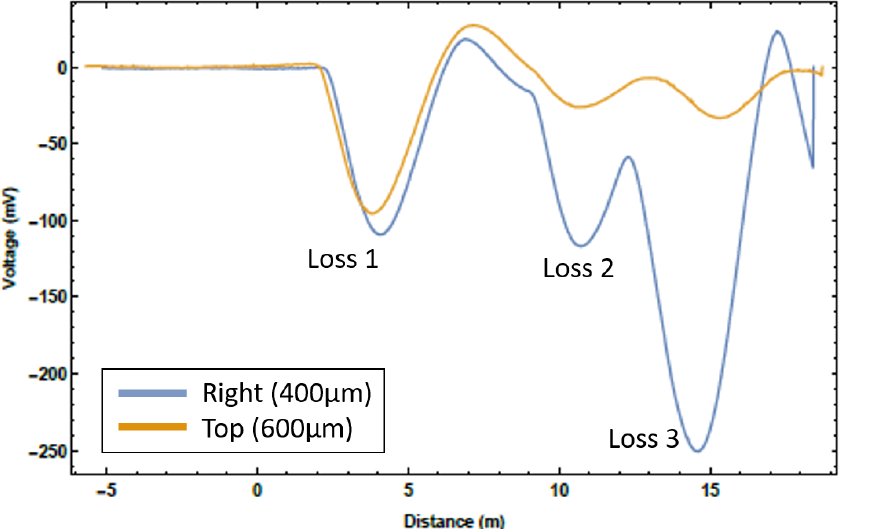
Figure 9. The Cherenkov signal for a three loss location scenario for two of the installed optical fibres. Only signals from two of the fibres are presented for clarity and the sharp peak on the far right is a reflection from the far end of the fibre.